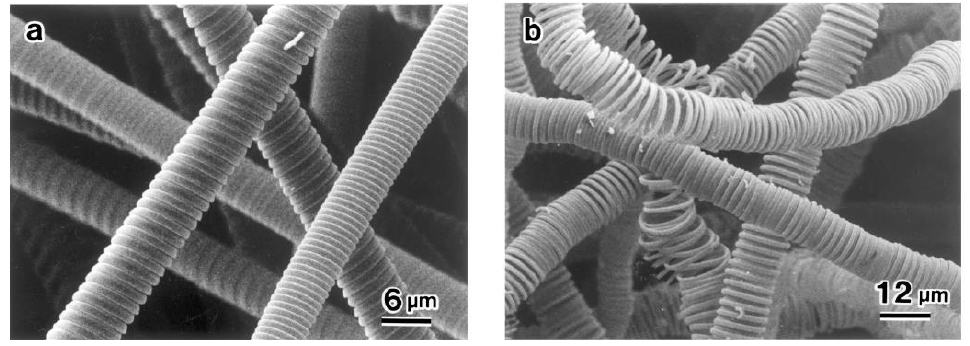
Figure 6. Effect of reaction temperature on the coil diameter: ( a ) regular carbon coils with small coil diameter, reaction temperature 750 °C; and ( b ) carbon coils with larger coil diameter and slightly irregular forms, reaction temperature 820 °C ([60], Chen and Motojima,